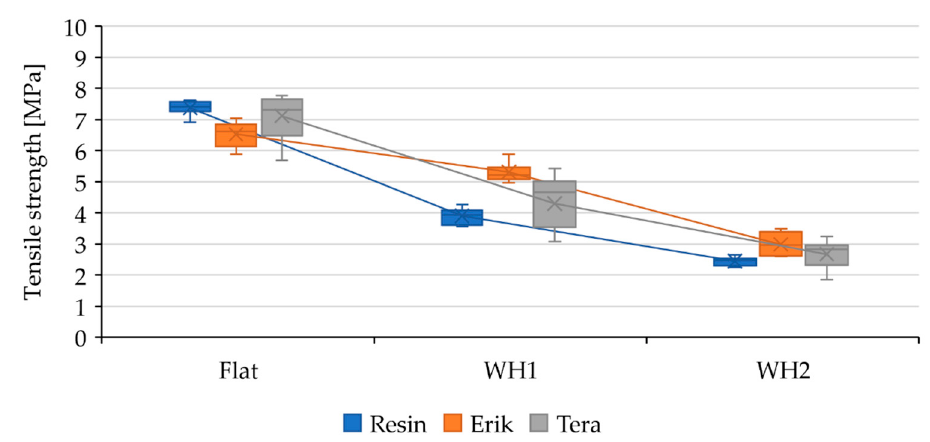
Figure 3. Evaluation of the tensile strength of adhesive bonds under static loading and their dependance on the bond shape.